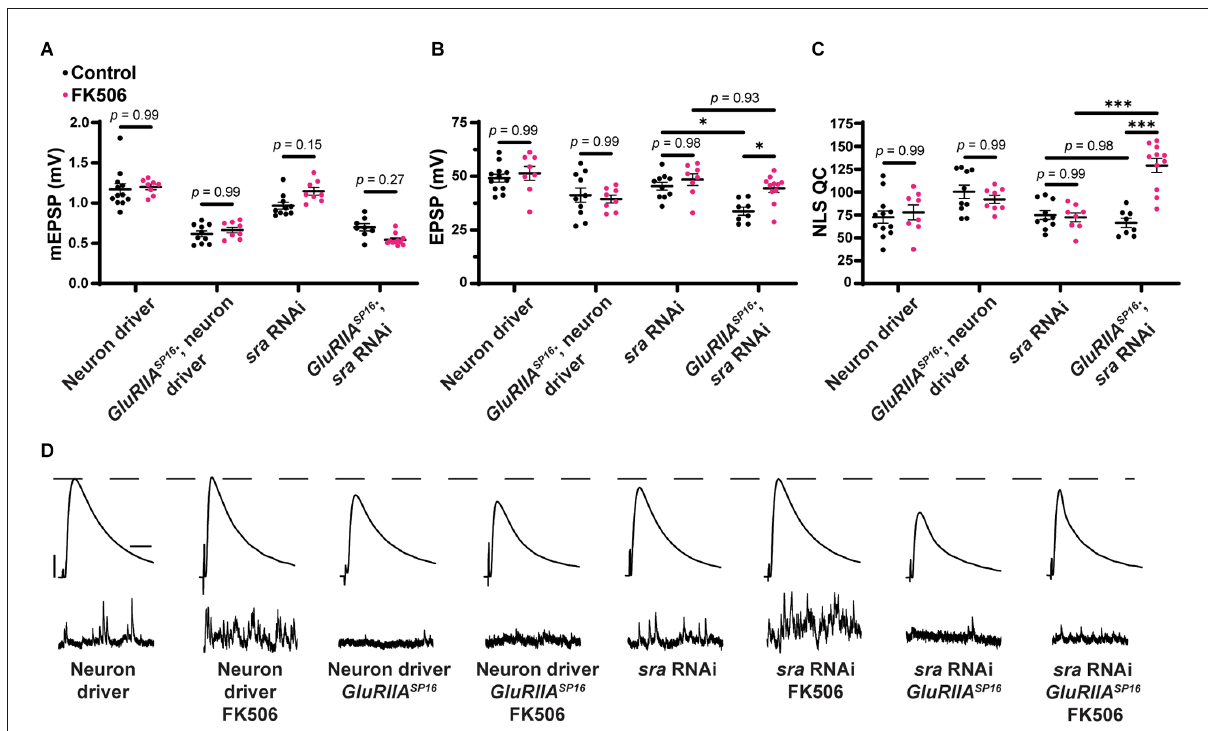
FIGURE10 Pharmacological inhibition of calcineurin rescues the PHP deficit observed in chronically challenged presynaptic knockdown of sra animals. (A–C) Quantification showing average mEPSP amplitude, EPSP amplitude, and NLS quantal content in pre-GAL4 control and pre-GAL4 driven sra knockdown in both the presence and absence of 50 µ M FK506. Black points show DMSO control synapses while dark pink points represent 50 µ M FK506. (D) Representative electrophysiological traces of EPSPs (above) and mEPSPs (below). Scale bars for all traces are y = 10 mV (1 mV), x = 20 ms (500 ms) for EPSPs (mEPSPs). Two-way ANOVAs were used to compare each genotype with and without the drug followed by a Tukey’s HSD test for multiple comparisons. ∗ p < 0.05, ∗∗∗ p <